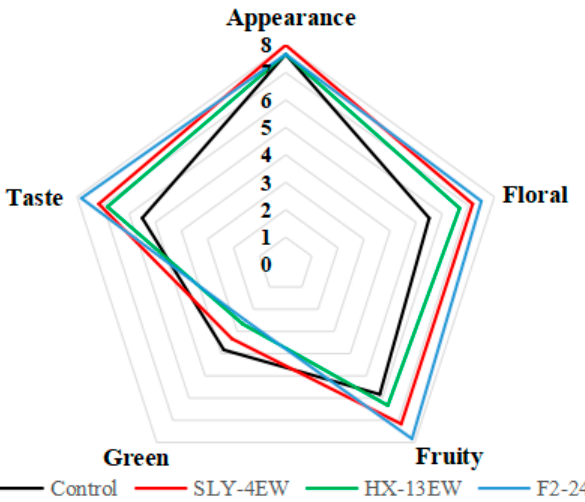
Figure 5. Sensory evaluation of wines .